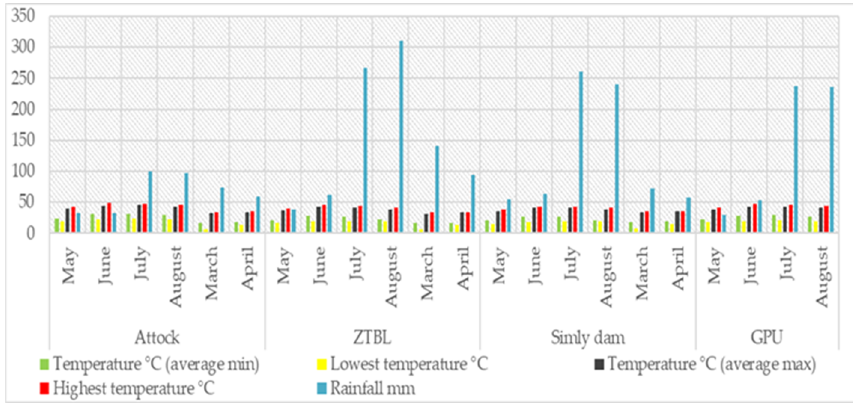
Figure 2. Climatic factors recorded at different locations.